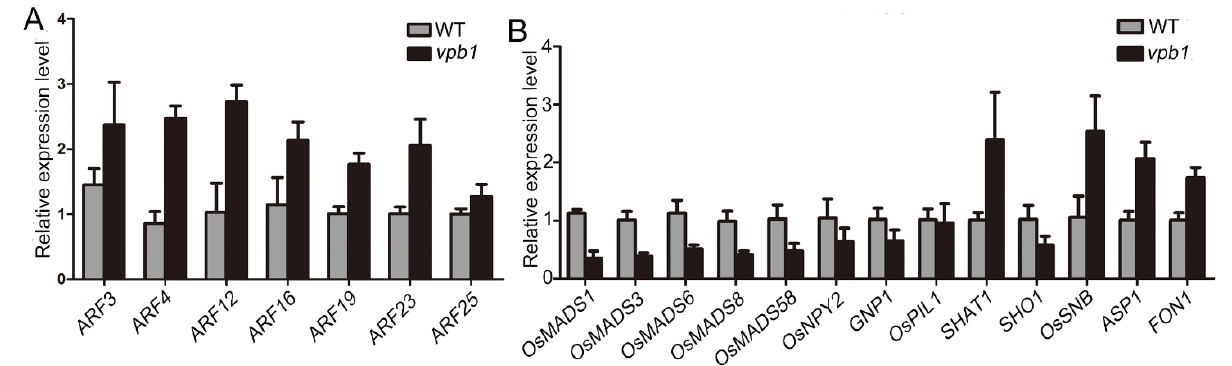
Figure 7. VPB1 regulates genes involved in hormone signaling and meristem maintenance. ( A ) Expression analysis of the auxin responsive factor genes in WT and vpb1 young panicles. Data are mean ± SD. ( n = 3 biological replicates). ( B ) Ex- pression analysis of the related to meristem maintenance genes in WT and vpb1 young panicles. Data are mean ± SD. ( n = 3 biological replicates).